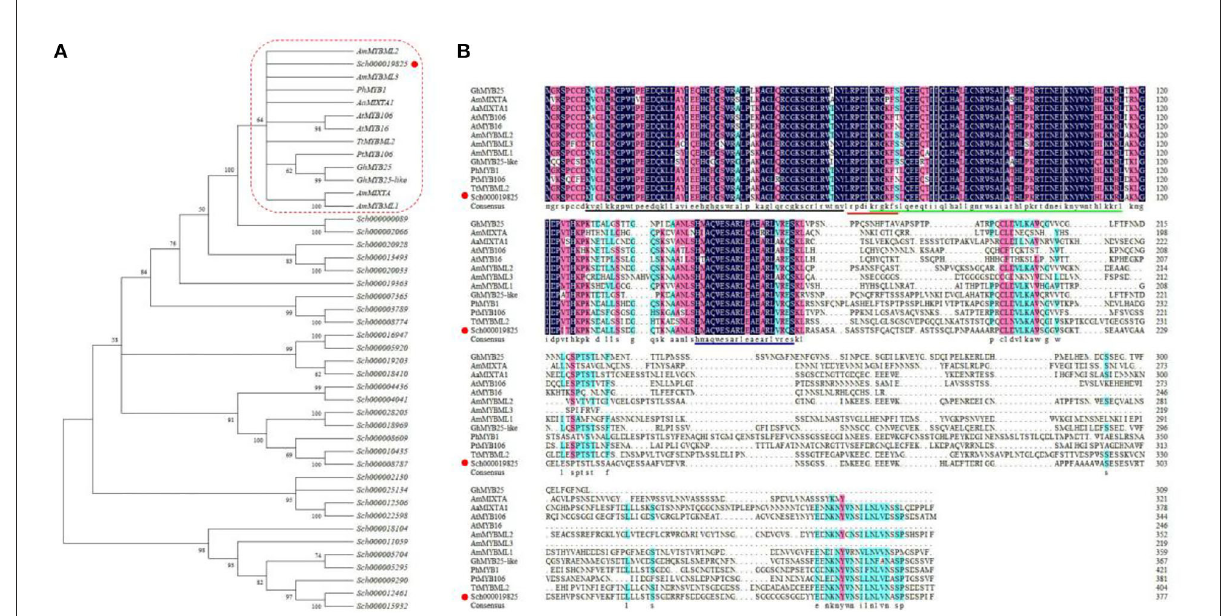
FIGURE1 Sequence analysis of NtMIXTA1. (A) ML (Maximum-likelihood) tree of R2R3 SBG9 proteins. Arabidopsis thaliana (At), Petunia hybrida (Ph), Artemisia annua (Aa), Gossypium hirsutum (Gh), Thalictrum thalictroides (Tt), Antirrhinum majus (Am), and Populus trichopoda (Pt). (B) Alignment of the protein sequences of NtMIXTA1 and reported R2R3 SBG9 proteins. The R2 and R3 domain characteristics are shown with back and green lines; the conserved domain of subgroup 9 is blue; the red line indicates the putative nuclear localization signal